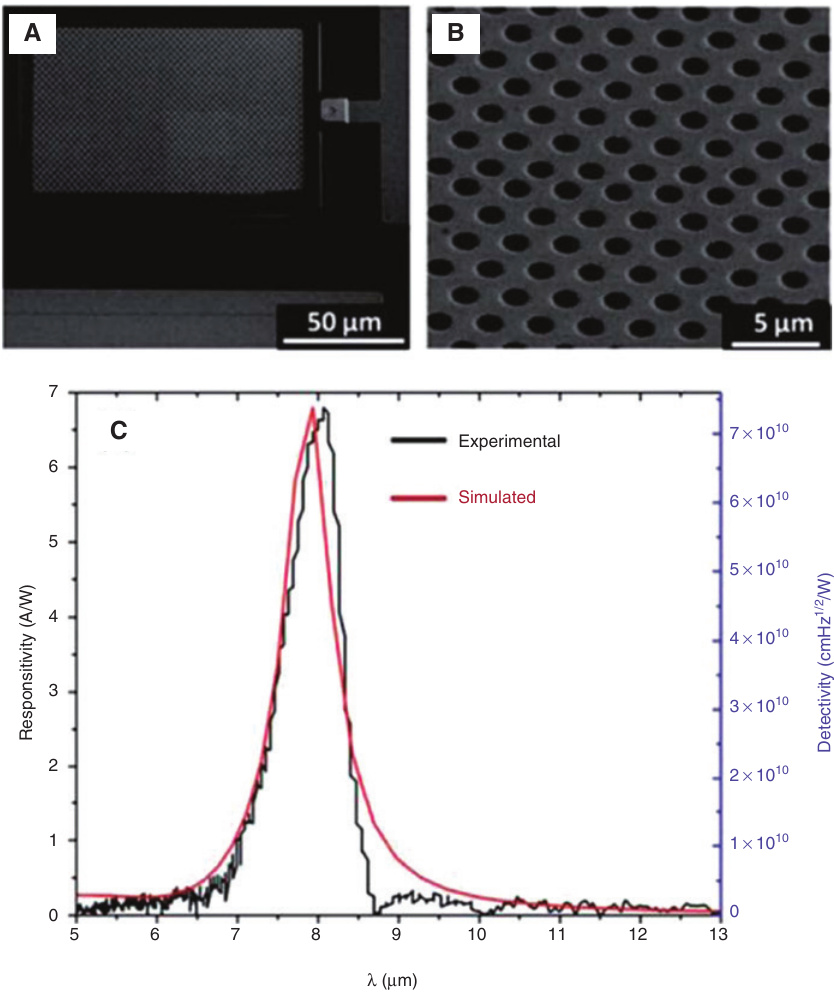
Figure 15: An ultra-thin QWIP integrated with a nanohole-array optical antenna. (A and B) SEM images of nanohole array optical antenna integrated on a QWIP photodetector. (C) The measured responsivity of the device at bias 0.7 V at 78 K